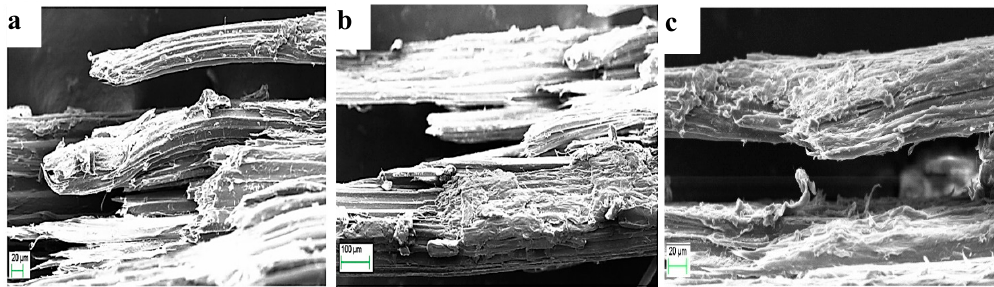
Figure 2. Microstructure of the surface of 2 wt.% NaOH-treated concentration the single-cellulosic Buluh semantan strips after soaking for 12 h in 2 wt.% NaOH showing in ( a – c ) fractured fibers in di ff erent magnification.